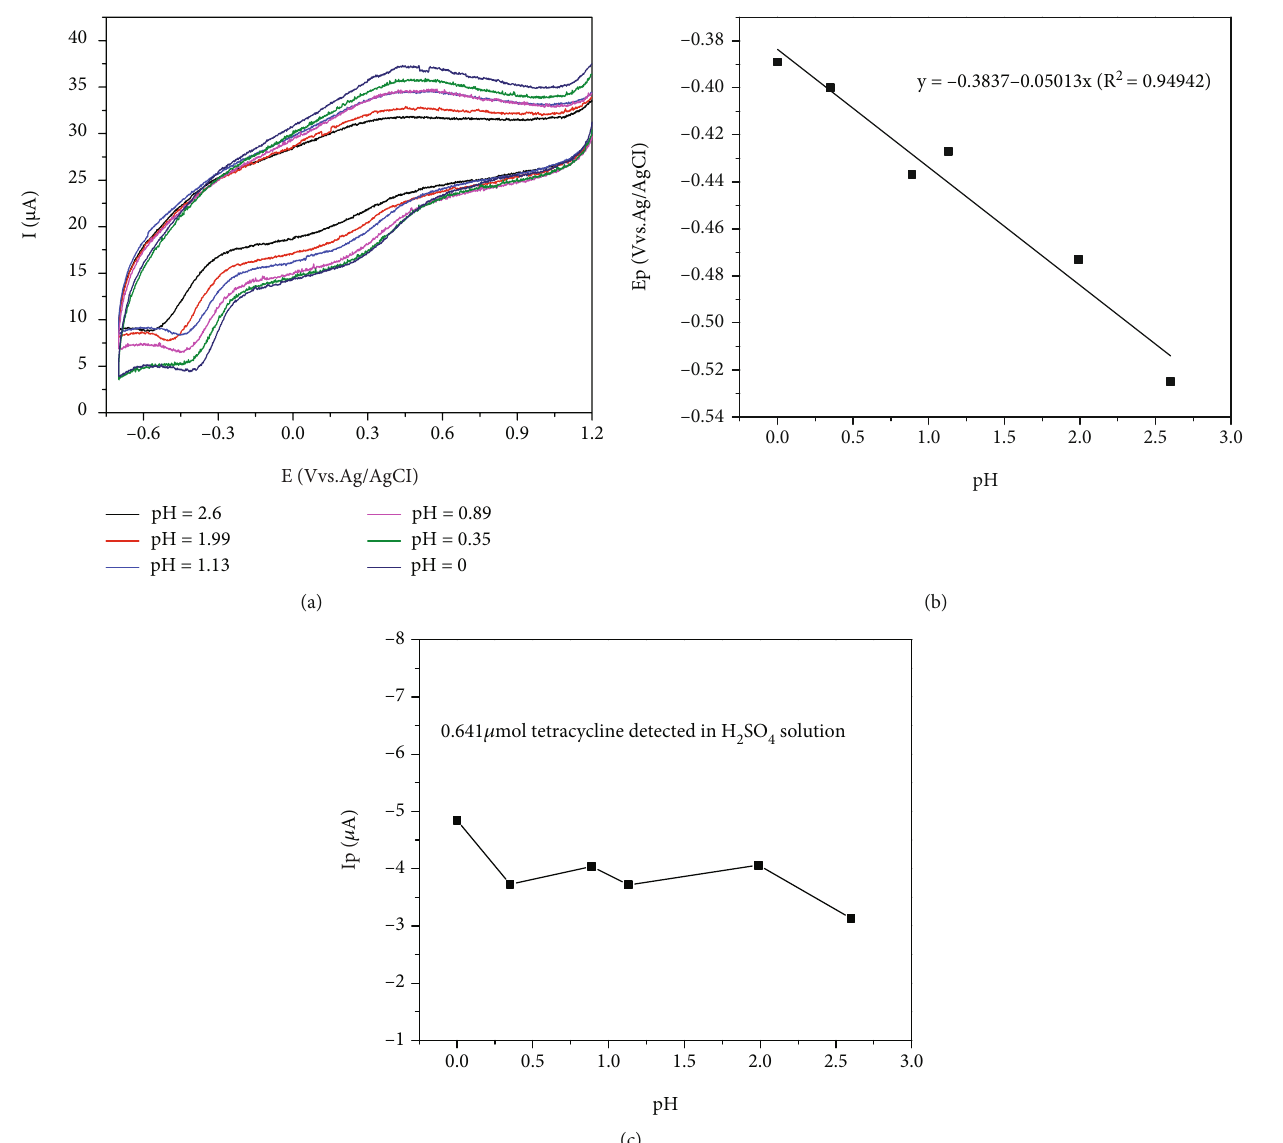
Figure 4: (a) CVs of 0.641 μ M tetracycline over MIL-53 (Fe)/GCE in H of E p with pH. (c) The dependence of I p with